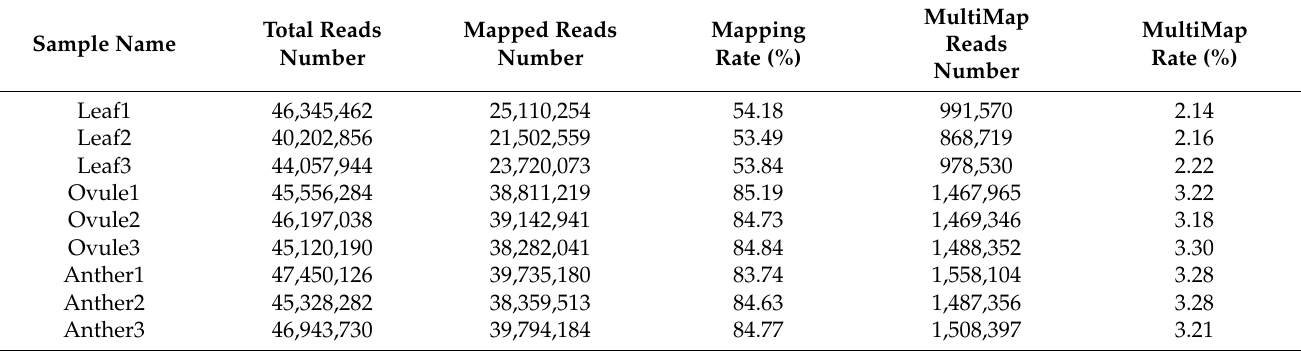
Table 2. Statistics for clean reads mapped in the Brassica